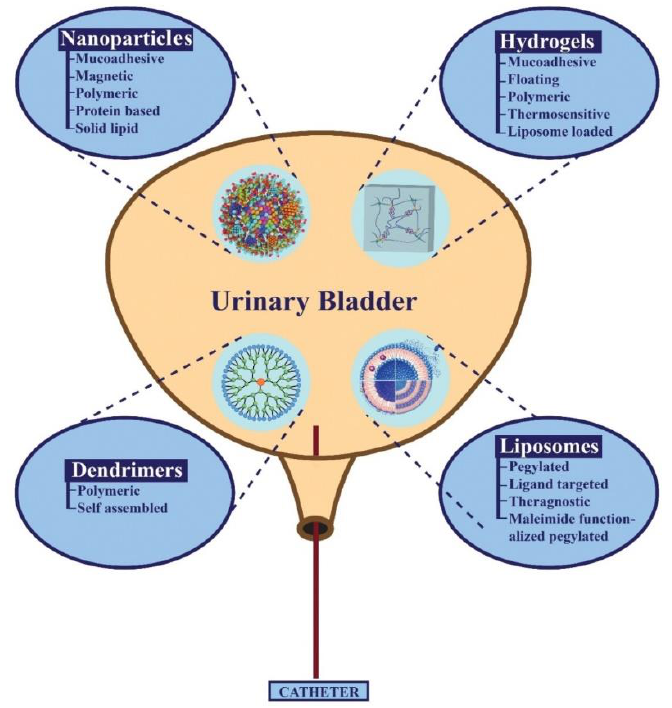
Figure 2. Different types of nano-formulations that can be employed as effective vehicles in IDD to cure various bladder-related diseases .